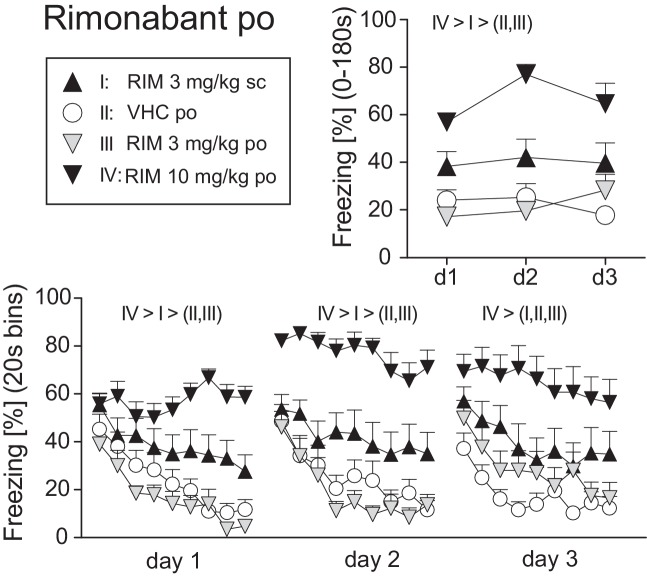
Effects of systemic rimonabant treatment on the expression of auditory-cued fear memory. Freezing responses (mean ± S.E.M.) of the animals after per os (RIM: 0, 3, or 10 mg/kg) or subcutaneous rimonabant (RIM: 3 mg/kg) treatment before re-exposure to the 3 min tone at days 1–3 after conditioning (day 0) averaged over the entire 180 s tone presentation (upper right) or in 20-s interval (lower panel). n = 11–13 mice per group. Data were analyzed by two-way ANOVAs for repeated measurements. Newman-Keuls post-hoc comparisons for the main effects Treatment are indicated above the graphs. For the matter of clarity, we do not report post-hoc results in case of factorial interactions.